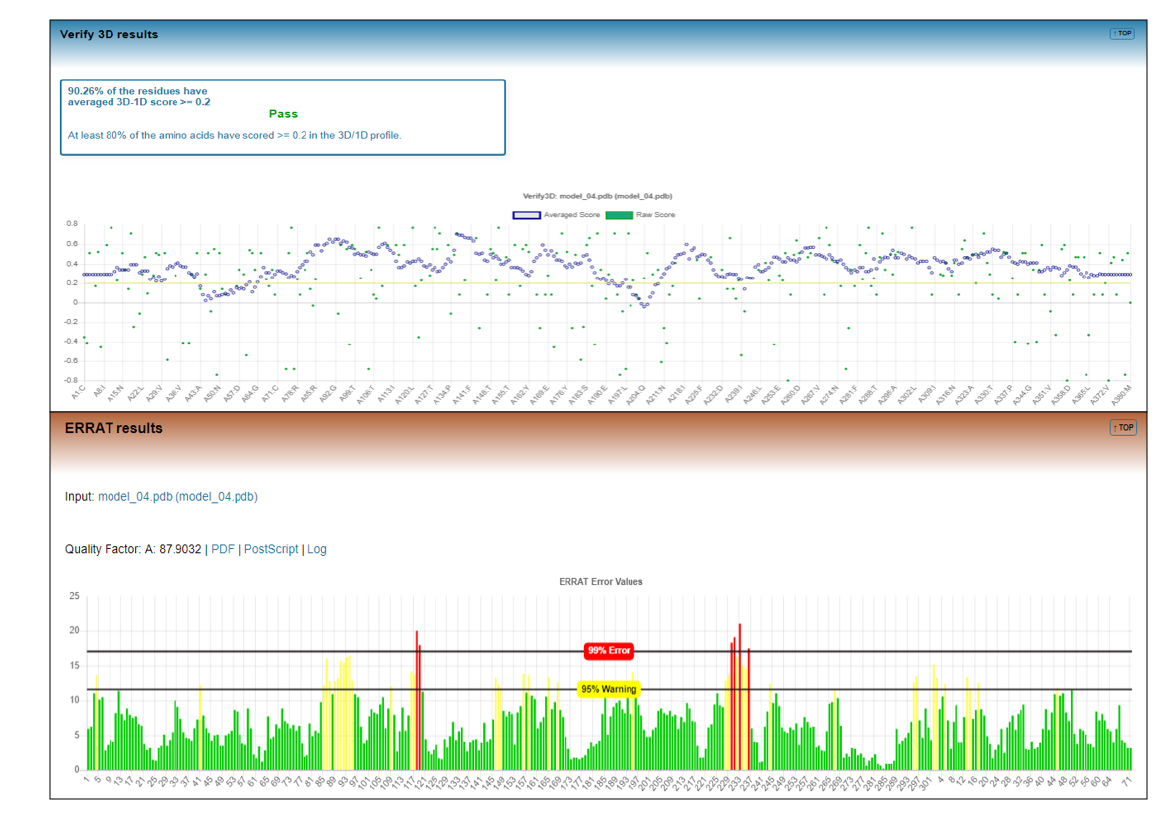
Figure 3. Verify 3D and ERRAT Plot.